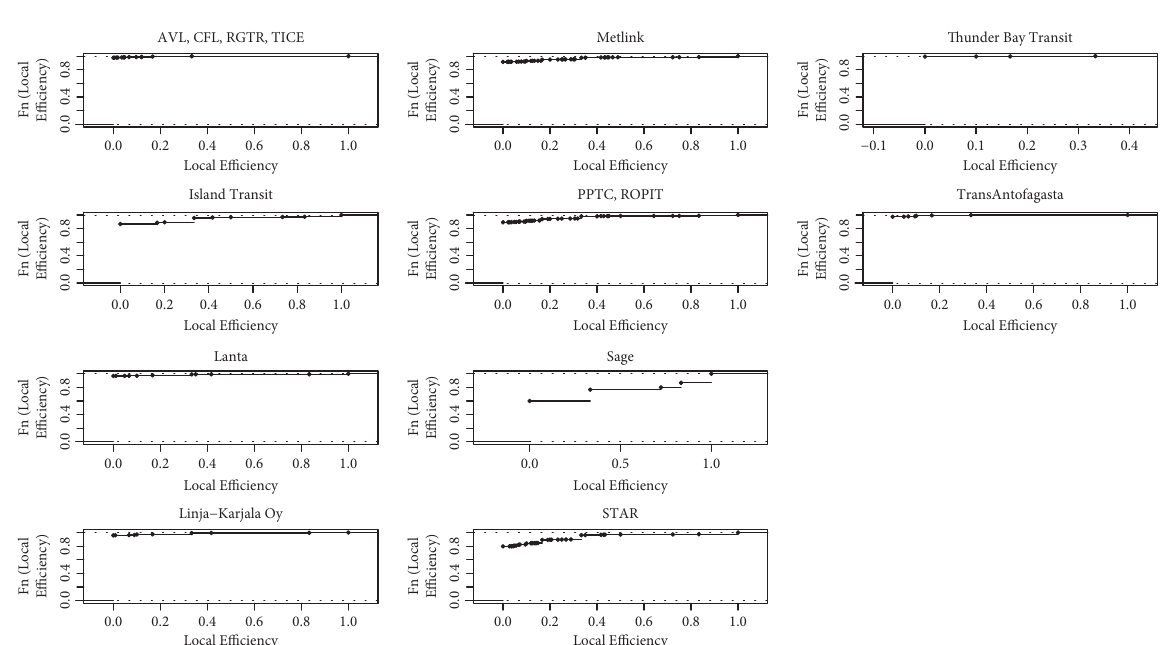
Figure 4: Cumulative probability distribution of local efficiency.